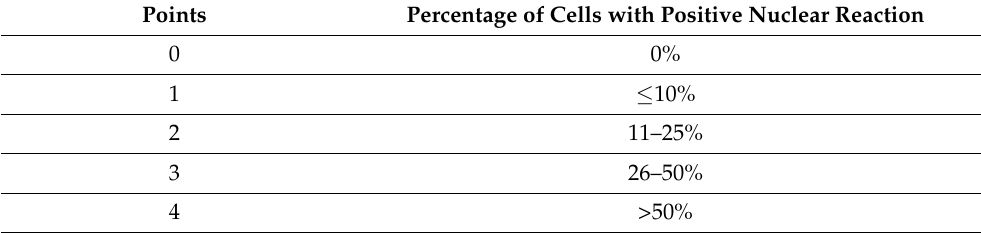
Table 2. Scoring system for nuclear reaction intensity (modified according to [27]).